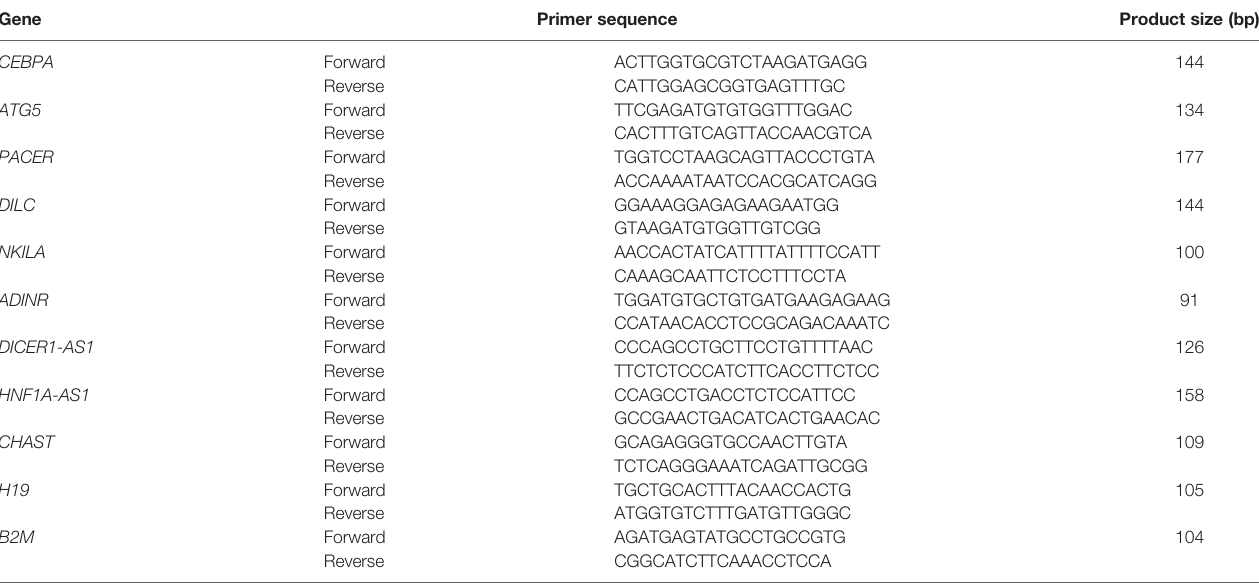
TABLE 1 | Primer sequences.